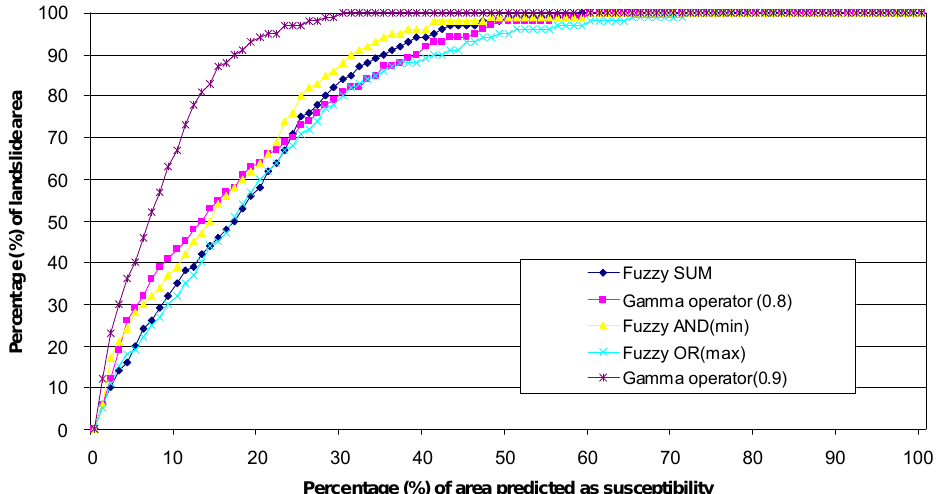
Fig. 3. Success rate evaluation of landslide susceptibility models using area under the curve